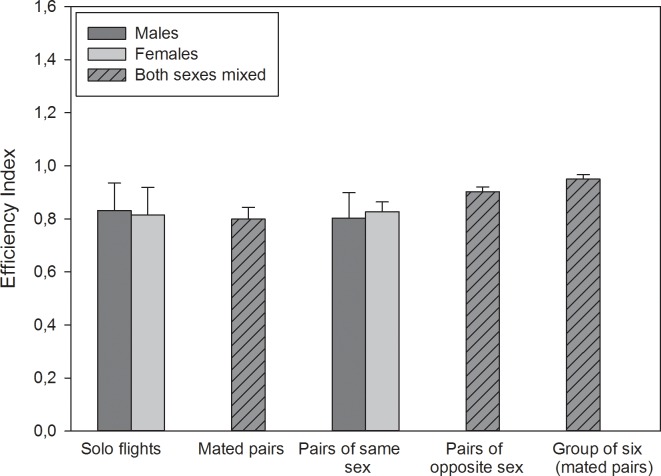
Efficiency indices (mean ± sd) of mated males and females in solo, duo, and group flights.See the main text and Table 3 for statistical results.